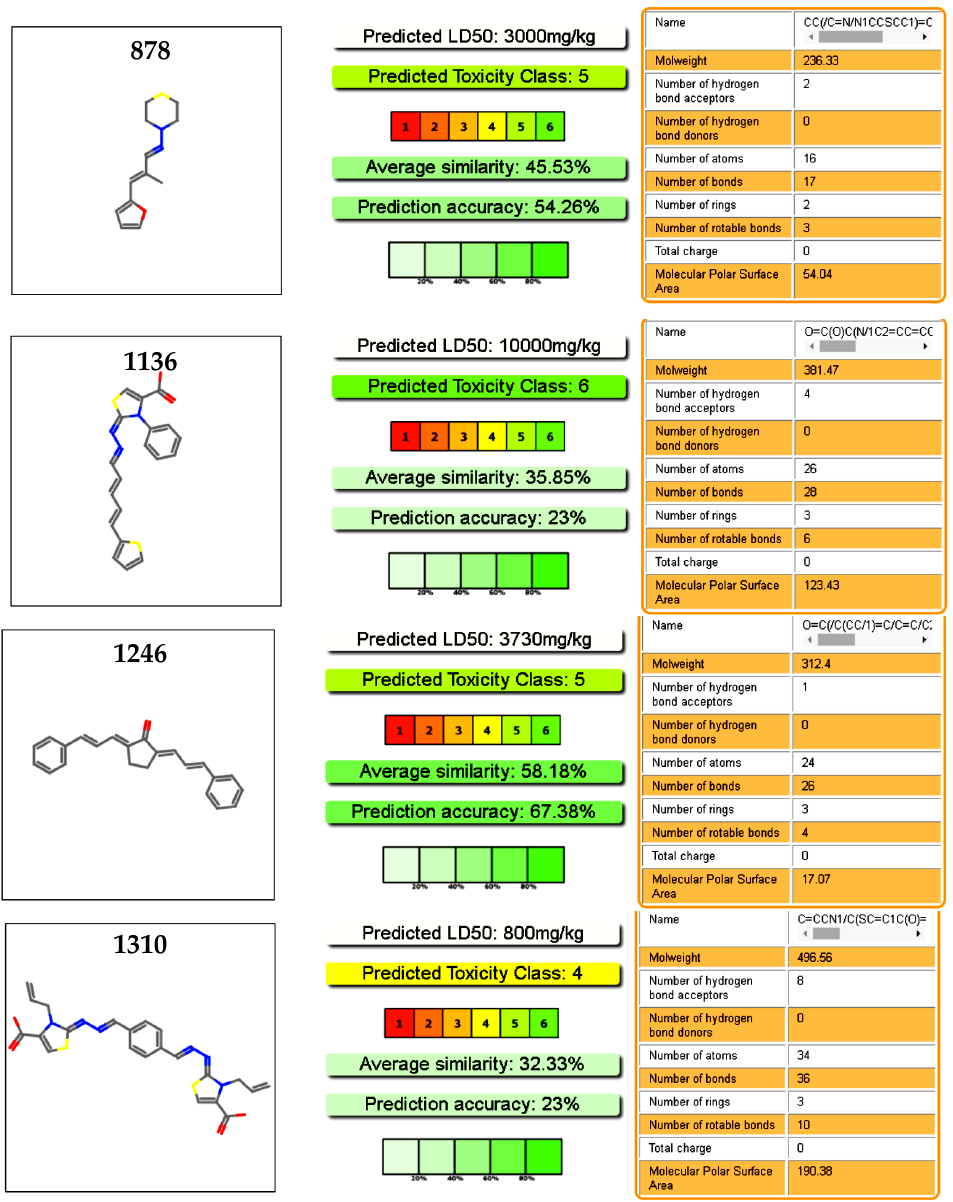
Figure 7. Toxicology profiles of the studied compound calculated from PROTOX (Charite University of Medicine Institute for Physiology Structural Bioinformatics Group Philippstrasse 12, 10115 Berlin, Germany)